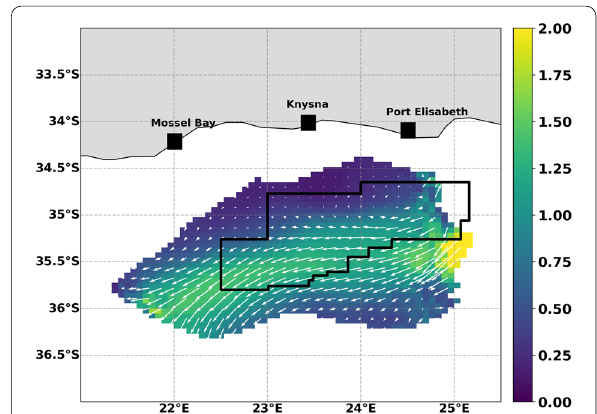
Fig. 2 Black squares represent the emplacement of the HF radar installed to monitor the area delimited by the black contour (cf Fig. 1). The colored area represents the intensity of the averaged current measured by the radar during April 2020 and the white arrows are representative of the averaged direction of the surface currents during the same